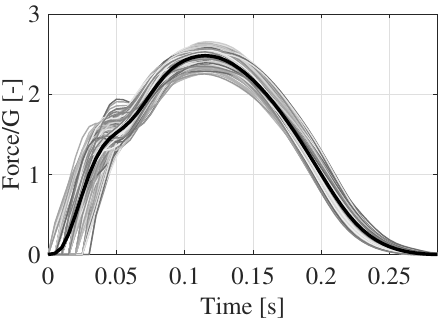
Figure 3. For participant 1 test 1: All identified single-step load patterns (gray) and the average single-step load pattern (black, thick line).